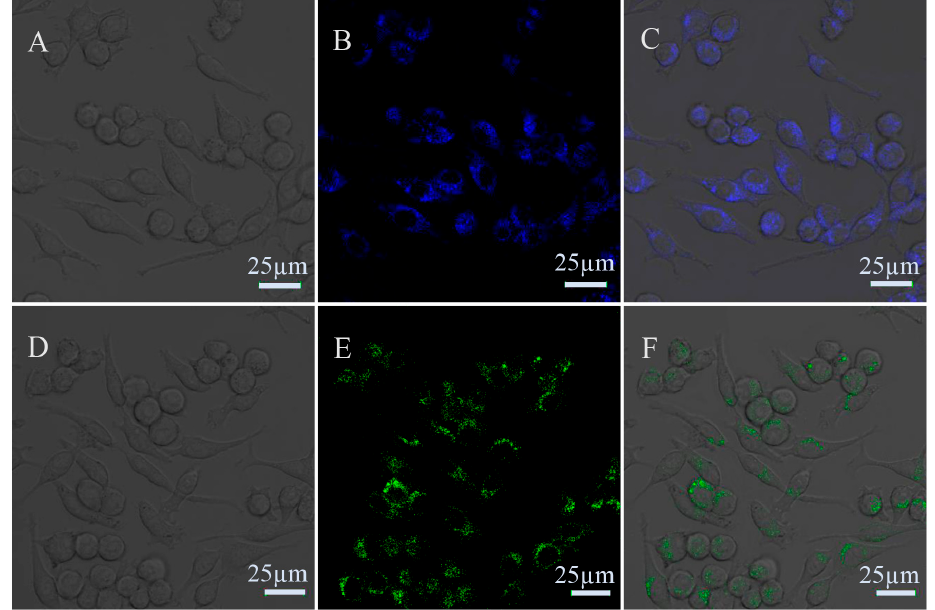
Figure 7. Laser scanning confocal fluorescence microscopy images of BV-2 cells: ( A , D ) the cells imaged under bright field, ( B ) 405 nm laser excitation, ( C ) overlay of ( A , B ), ( E ) 488 nm laser excitation, and ( F ) overlay of ( D , E ).